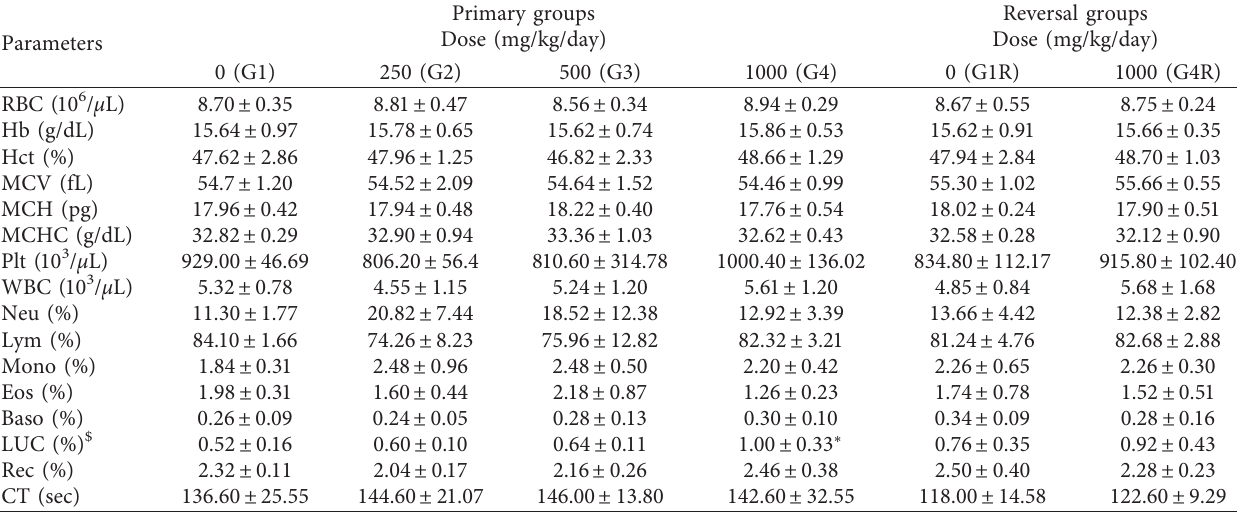
Table 8: Effect of oral administration of GMCT on hematology parameters in female Wistar rats.